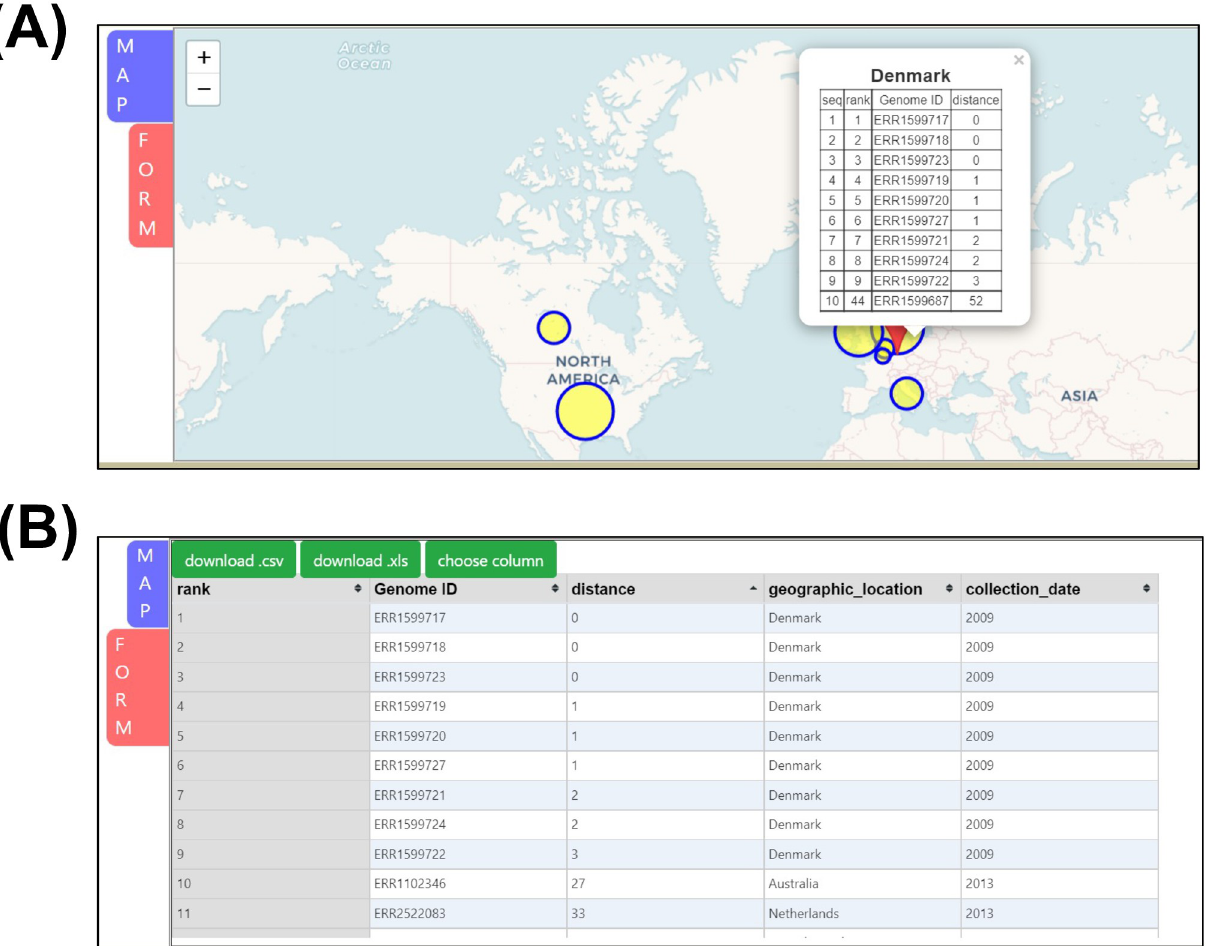
Fig 3. Example analysis. a) list of most similar isolates compared with uploaded isolate presented in LmTraceMap result page MAP tag; b) epidemiological table listing top 50 most similar isolates in result page FORM tag. (Base map and data from OpenStreetMap and OpenStreetMap Foundation. Reprinted from OpenStreetMap under a CC BY license, with permission from OpenStreetMap, original copyright 2020. © OpenStreetMap contributors. Annotated by the